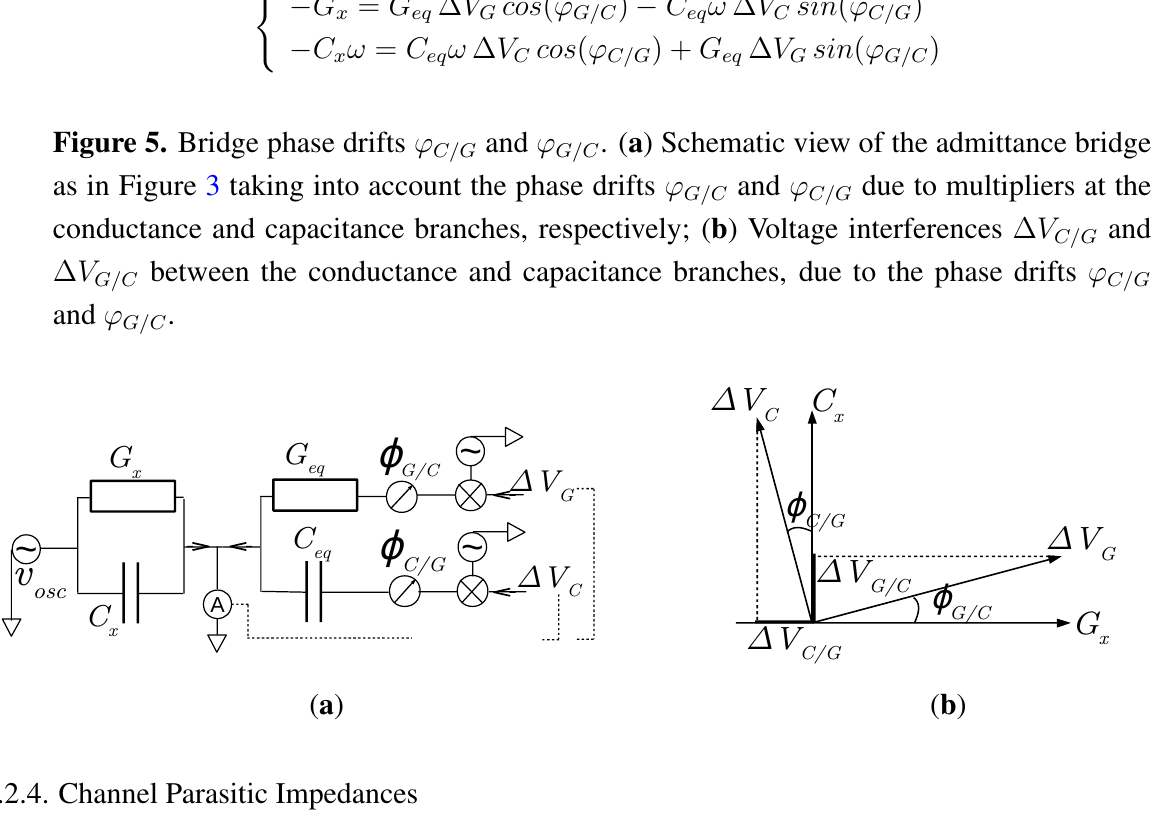
and ϕ . ( a ) Schematic view of the admittance C/G G/C